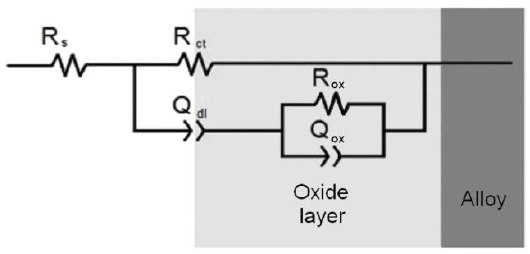
Figure 2. Equivalent electric circuit employed to fit the experimental EIS spectra.